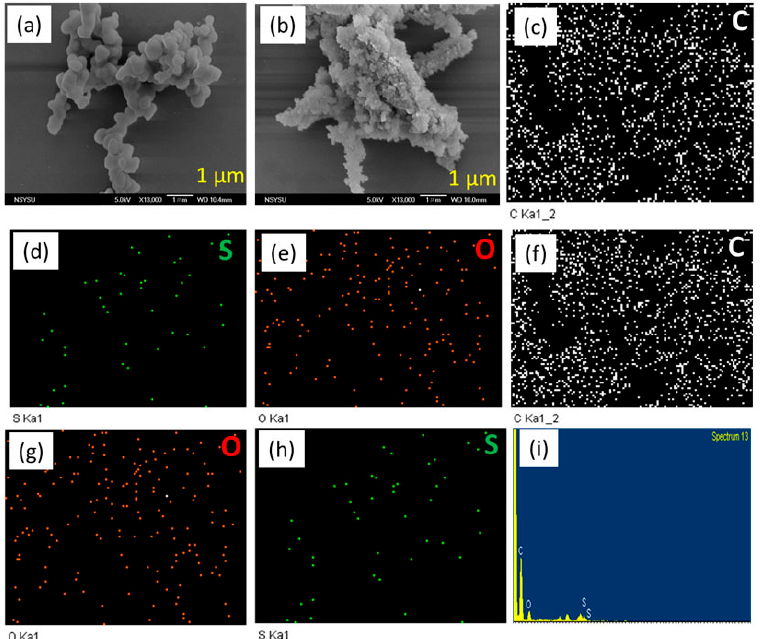
Figure 3. SEM images ( a , b ) and EDS-SEM mapping ( c – i ) of Py-BSU CMP ( a , c – e ) and TBN-BSU CMP ( b , f – i ). ( b , f – i ).